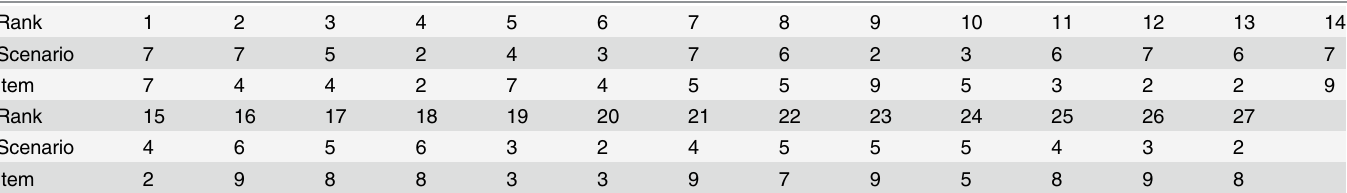
Table 3. Item ranking in terms of correlation with total